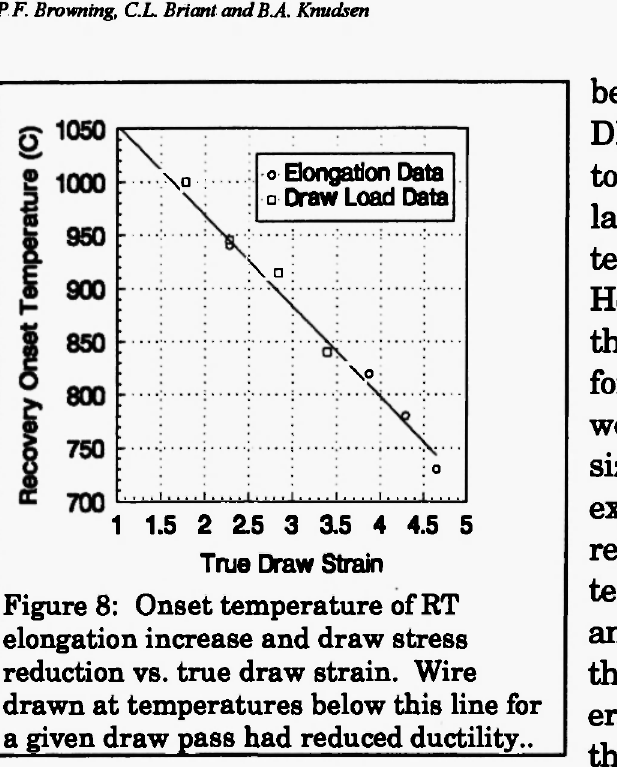
Figure 8: Onset temperature of RT elongation increase and draw stress reduction vs. true draw strain. Wire drawn at temperatures below this line for a given draw pass had reduced